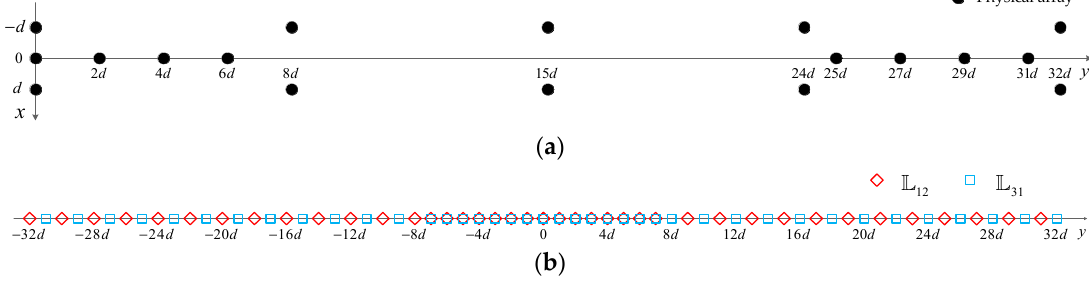
Figure 2. An example of TPNAs-I, where N 1 = 8, N 2 = 5. ( a ) physical array; ( b ) the corresponding difference coarray consist of L 12 and L 31